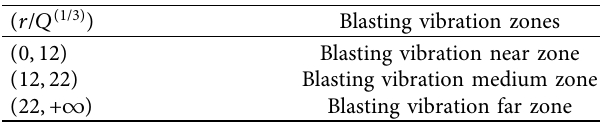
Table 2: Blasting vibration zoning method based on scaled